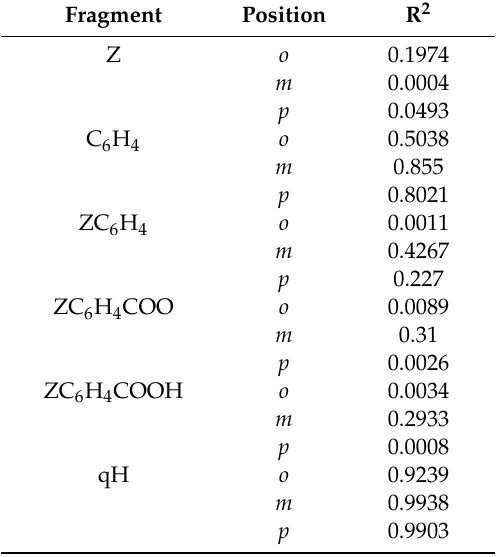
Table 2. Two parameter correlation analysis ∆ acid G ◦ (kcal / mol) = b + m S fragment (eV -1 ) for 1a – 6c .